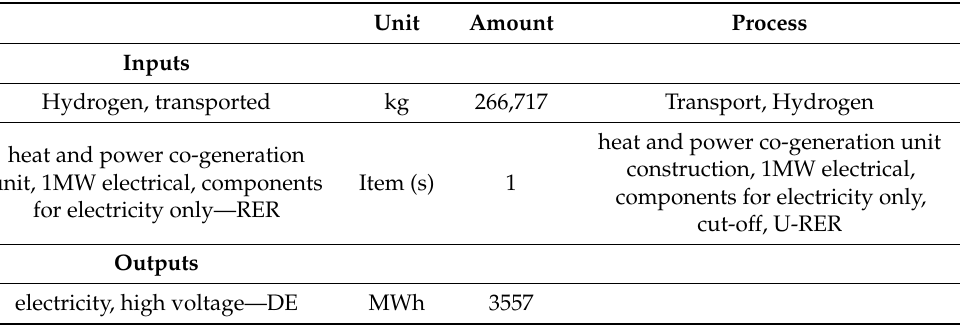
Table A12. Reconversion, Hydrogen.